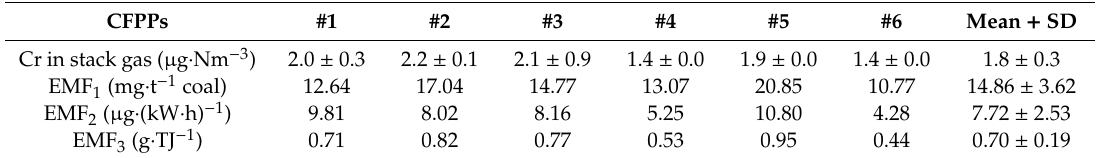
Table 5. Particulate-bound chromium in the stack gas of the six CFPPs and atmospheric emission factors